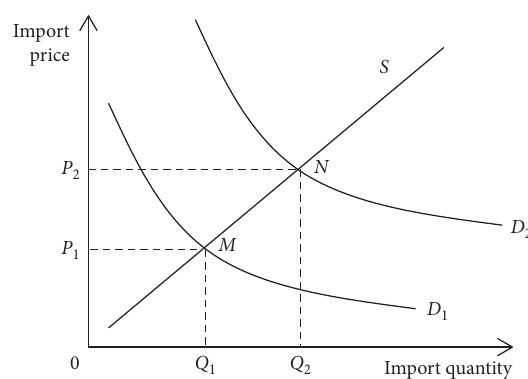
Figure 5: The principle of the great country effect in import